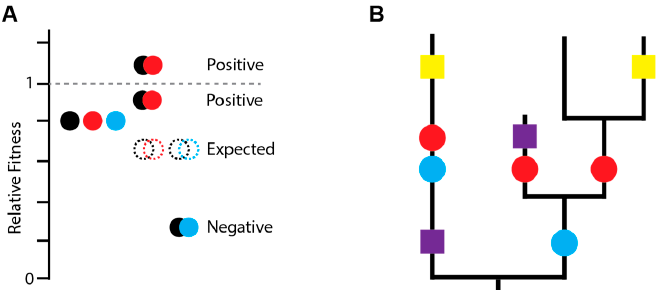
Figure 1. Identifying epistasis. ( A ) Epistasis is defined based on deviation from the expected fitness assuming independent multiplicative effects. Black, red, and blue mutations are each deleterious (filled individual circles) and the expected fitness of pairwise combinations (empty circles) is shown. Black and red mutations exhibit positive epistasis because combining them is not as deleterious as expected and may even increase fitness. Black and blue mutations exhibit negative epistasis because combining them is more deleterious than expected. ( B ) Positive epistasis can be inferred phylogenetically. Red and blue mutations interact positively as they are always present together and occur closely in time. In contrast, yellow and purple mutations do not occur closely in time and are not necessarily present together.